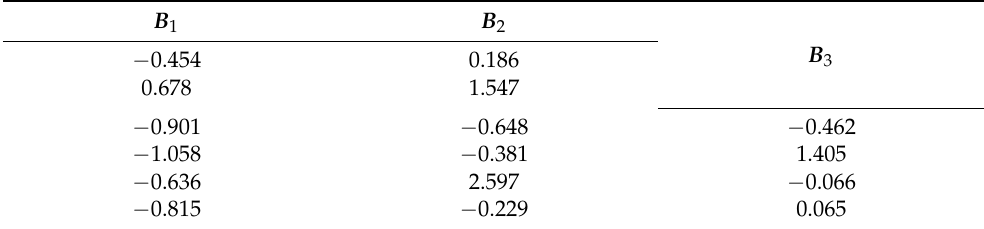
Table 4. Weights and biases of each node of the classification model. B 1 (6 rows and 1 column), B 2 (6 rows and 1 column), B 3 (4 rows and 1